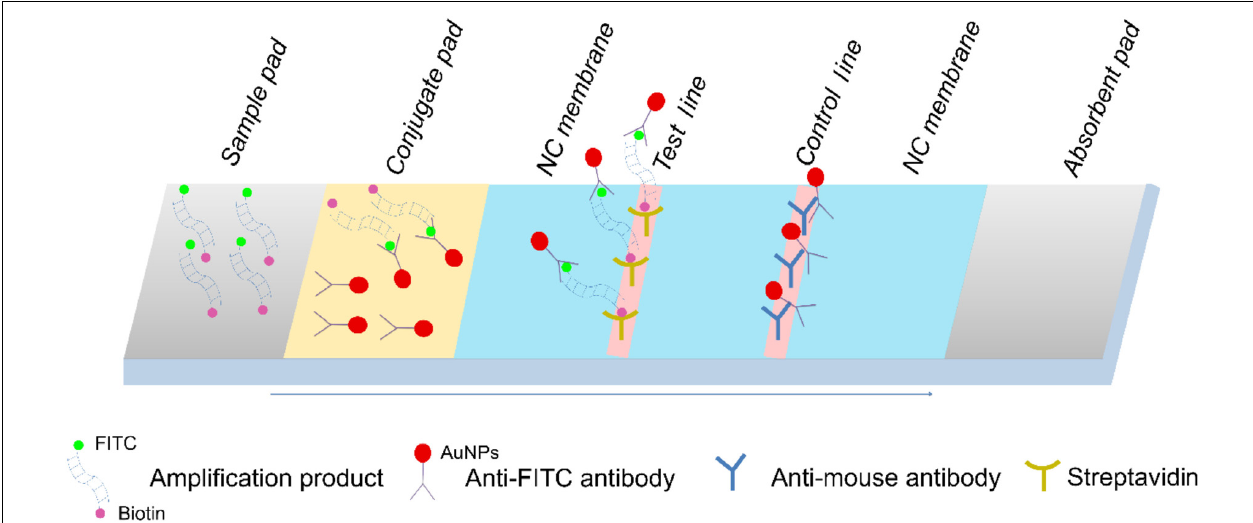
FIGURE 1 | Schematic representation of the lateral flow strip (LFS) working principle. The names of the segments of the strip were indicated on the top of the strip drawing. The sample pad is indicated by the gray parallelogram on the left, the absorbent pad is indicated by the gray parallelogram on the right, and the conjugate pad is shown in yellow. The liquid migration direction is indicated by an arrow. Molecules could be trapped by the materials on the test line, and the control line is indicated by different shapes. Shapes and their representing molecules are listed at the bottom of the image.